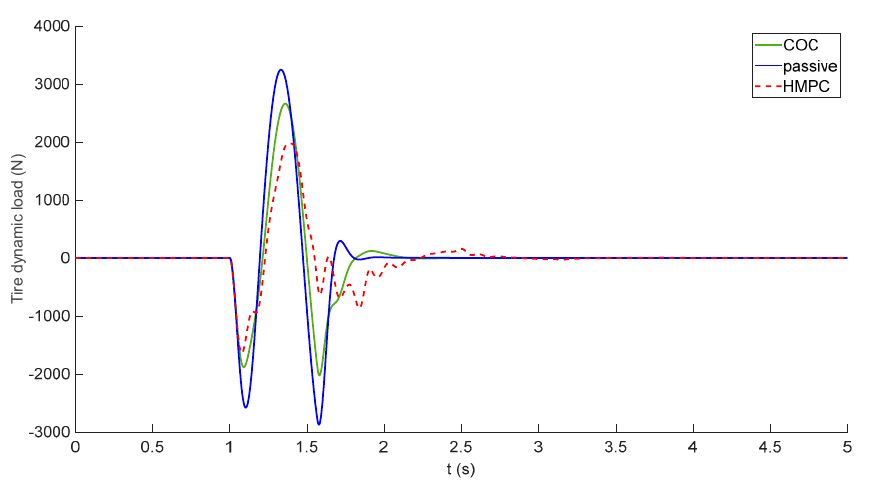
Figure 23. Tire dynamic load.